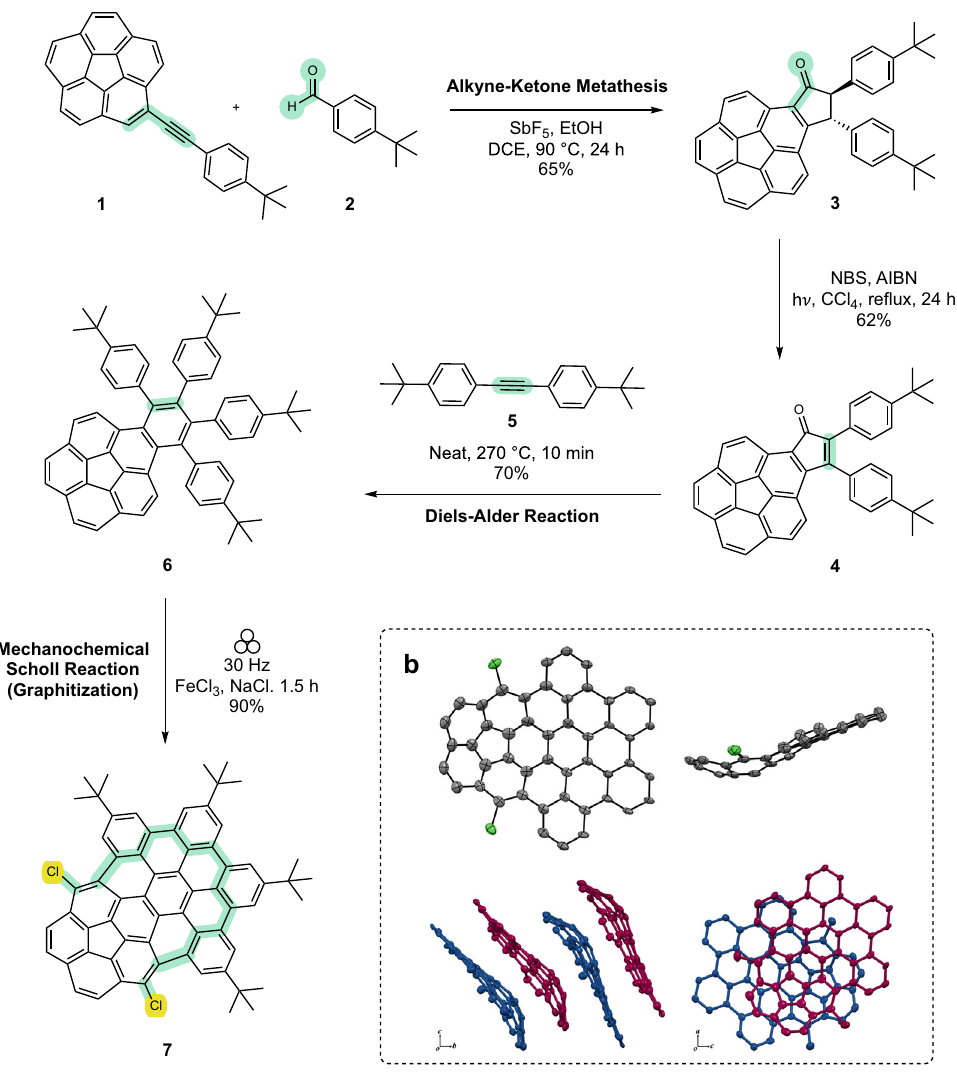
Fig. 1 | Synthesis and characterization. a Reaction sequence to obtain regiose- lectively chlorinated nanographenes. Reactive functional groups and newly formed bonds are highlighted. b X-Ray crystal structure of 7 . Thermal ellipsoids